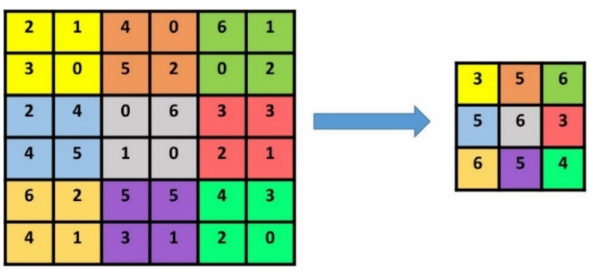
Figure 7. The maximum pooling function operation (2 × 2 filter and stride